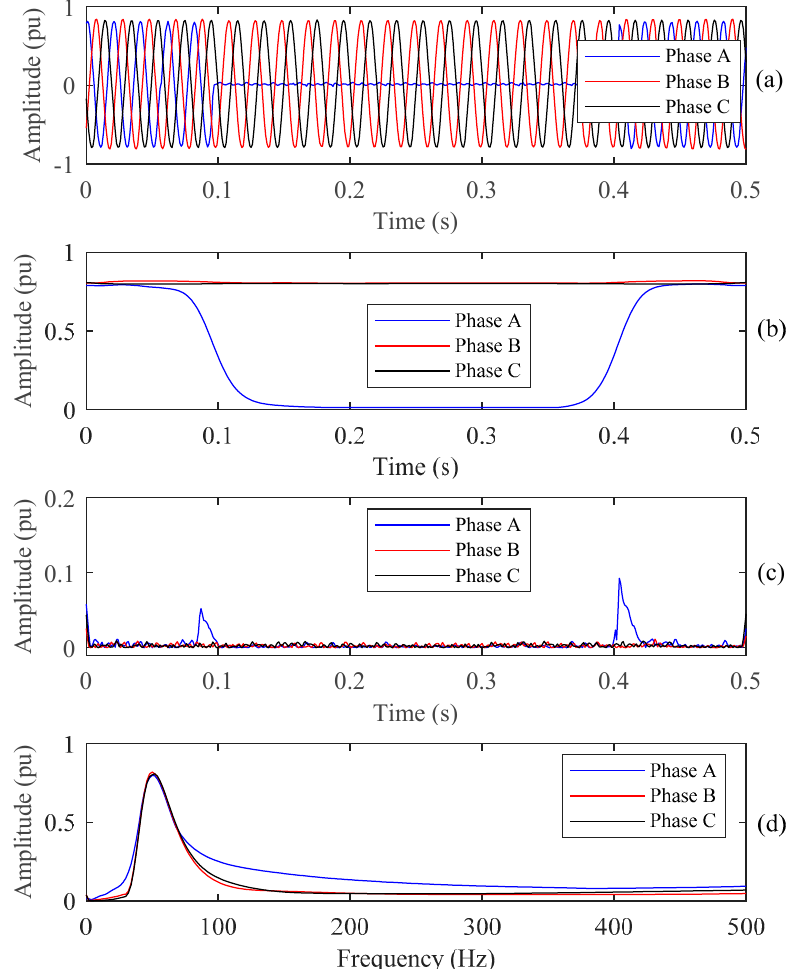
Figure 28. The processing results for the single-phase voltage interruption data recorded by Fluke 435 at the laboratory on 2 July 2020: ( a ) actual voltage waveform; ( b ) TvA ; ( c ) TvHFA ; ( d ) FvA .